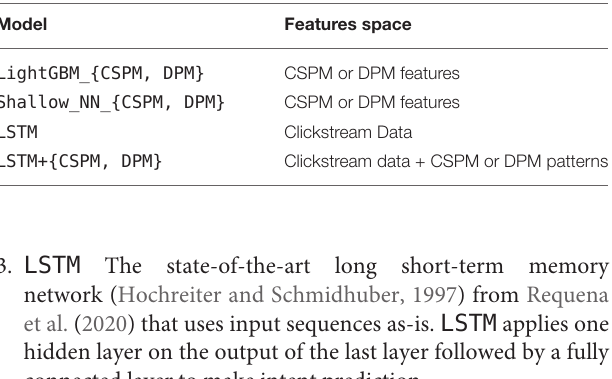
TABLE 4 | The set of machine learning models considered and their feature space.